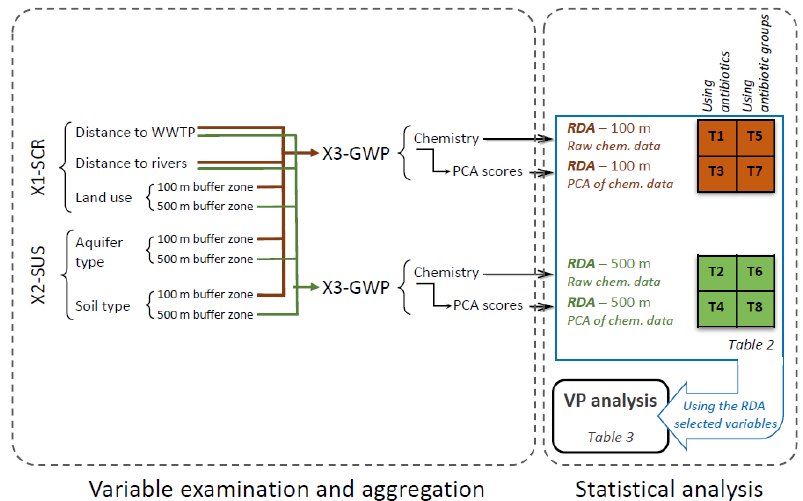
Figure 2. Distribution of the most frequent antibiotics detected in groundwater and surface water in the Baix Fluvià aquifer. The upper plots ( A ) include those samples with analytical values lower than analytical limits, to which a value of two-thirds of the detection limit was assigned. The lower plots ( B ) exclude these samples, and the numbers in parenthesis indicate the numbers of samples with measurable concentrations. H and V indicate human and veterinary use.